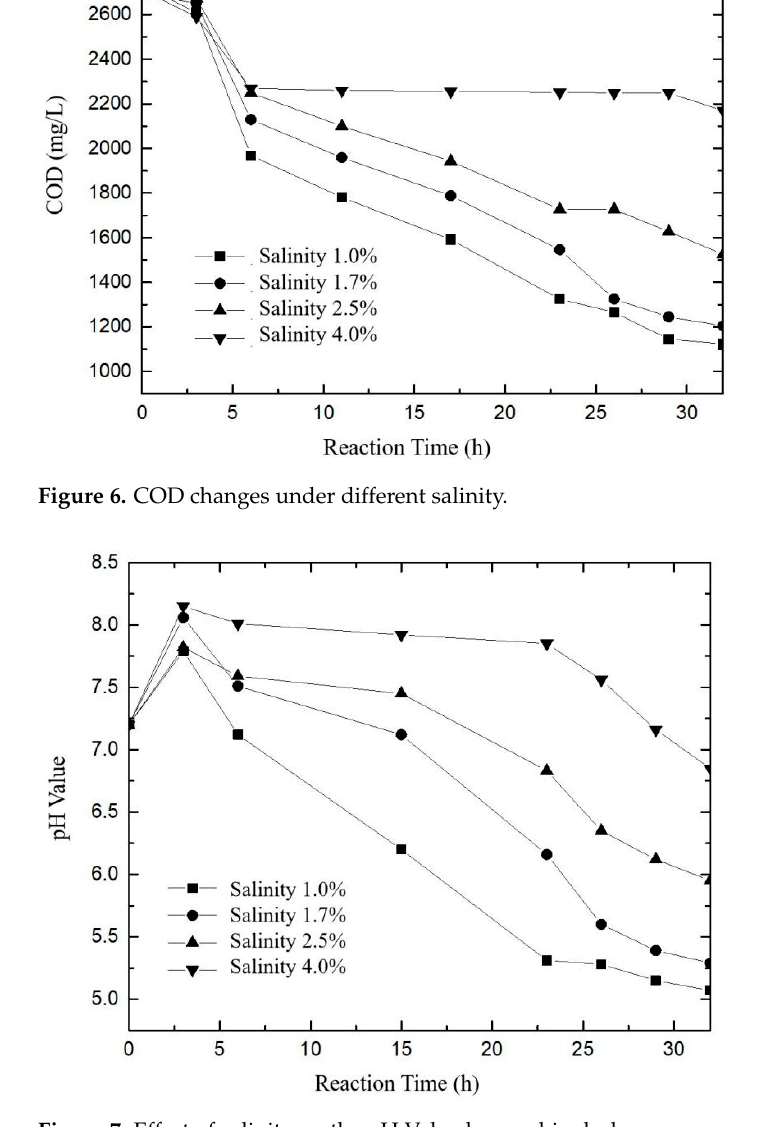
Figure 8. The relative percentages of the community constitution at the phylum level. As can be seen in Figure 9, the relative percentage of α -proteobacteria gradually in- creased, indicating that salinity had a significant effect on the composition of the bacterial